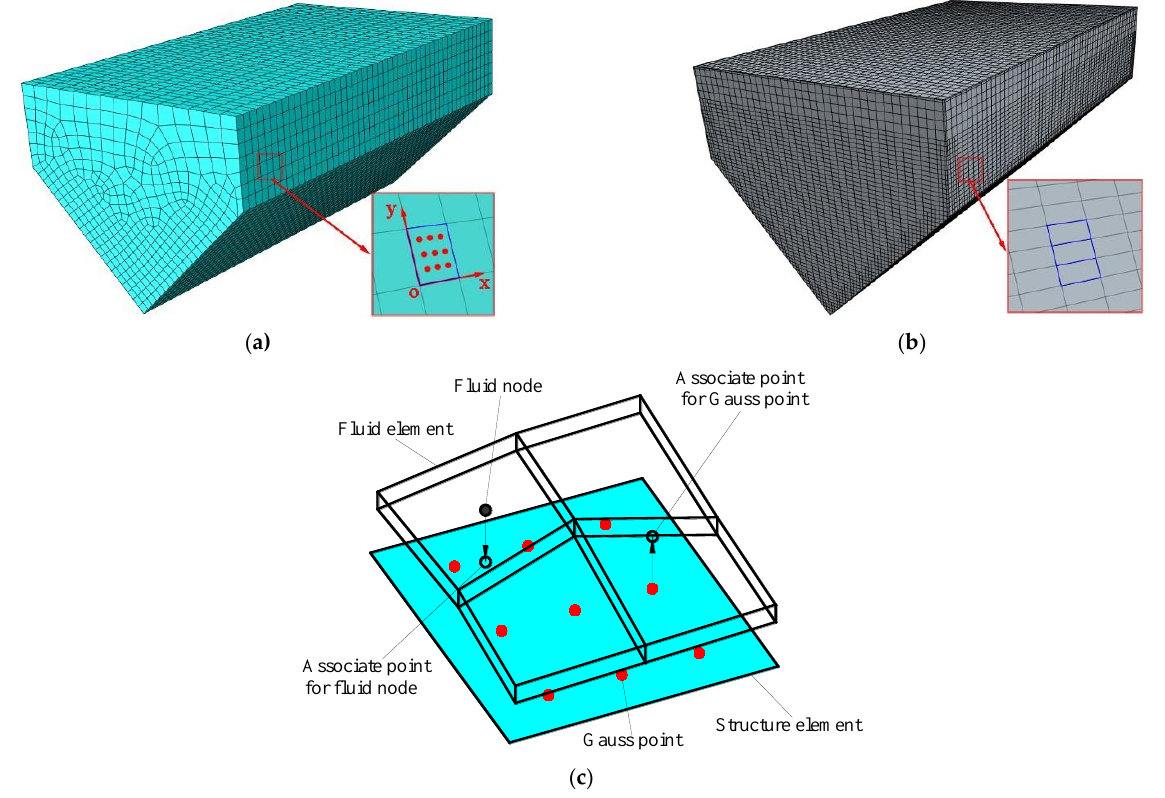
Figure 8. Mesh mapping between CFD and FEM meshes: ( a ) FEM mesh; ( b ) CFD mesh; ( c ) mesh mapping scheme.